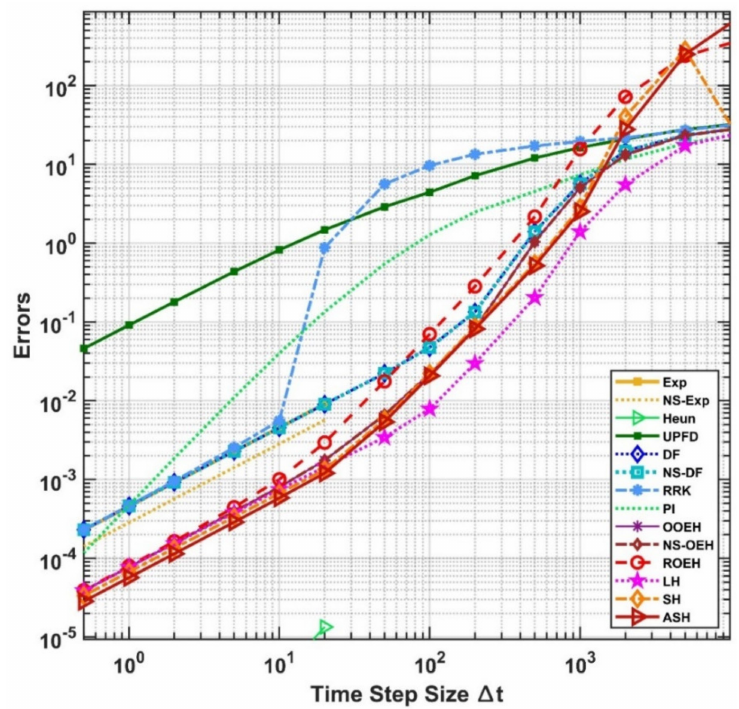
Figure 9. The maximum errors as a function of the time step size ∆ t for the equidistant